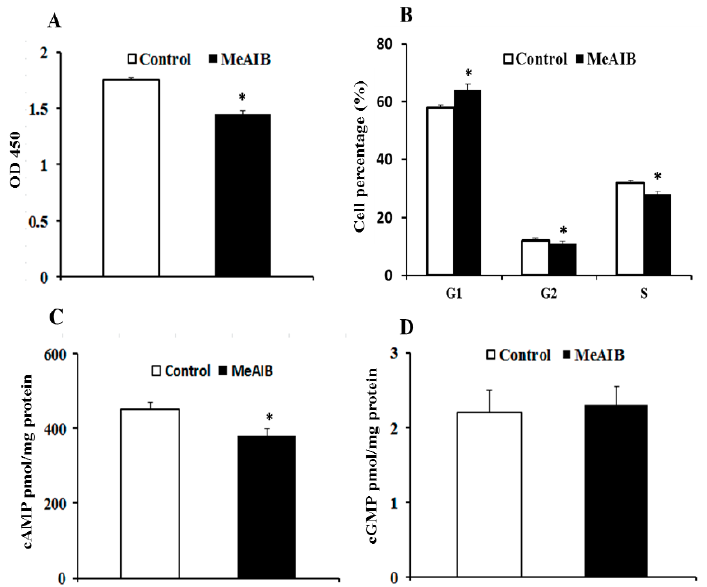
Figure 2. Effects of MeAIB on cell proliferation ( A ), cell cycle ( B ), intracellular cAMP ( C ), and cGMP ( D ) concentrations in IPEC-J2 cells. Cell proliferation was determined using the Cell Counting Kit-8 (CCK-8, Dojindo Molecular Technologies, Inc., Rockville, MD, USA) at 450 nm. Cell cycles were analyzed using propidium iodide DNA staining and Flow Cytometry. Intracellular cAMP and cGMP were determined by immunoassay. Data are expressed as mean ± SD, n = 4 independent experiments. * p < 0.05 versus control treatment.